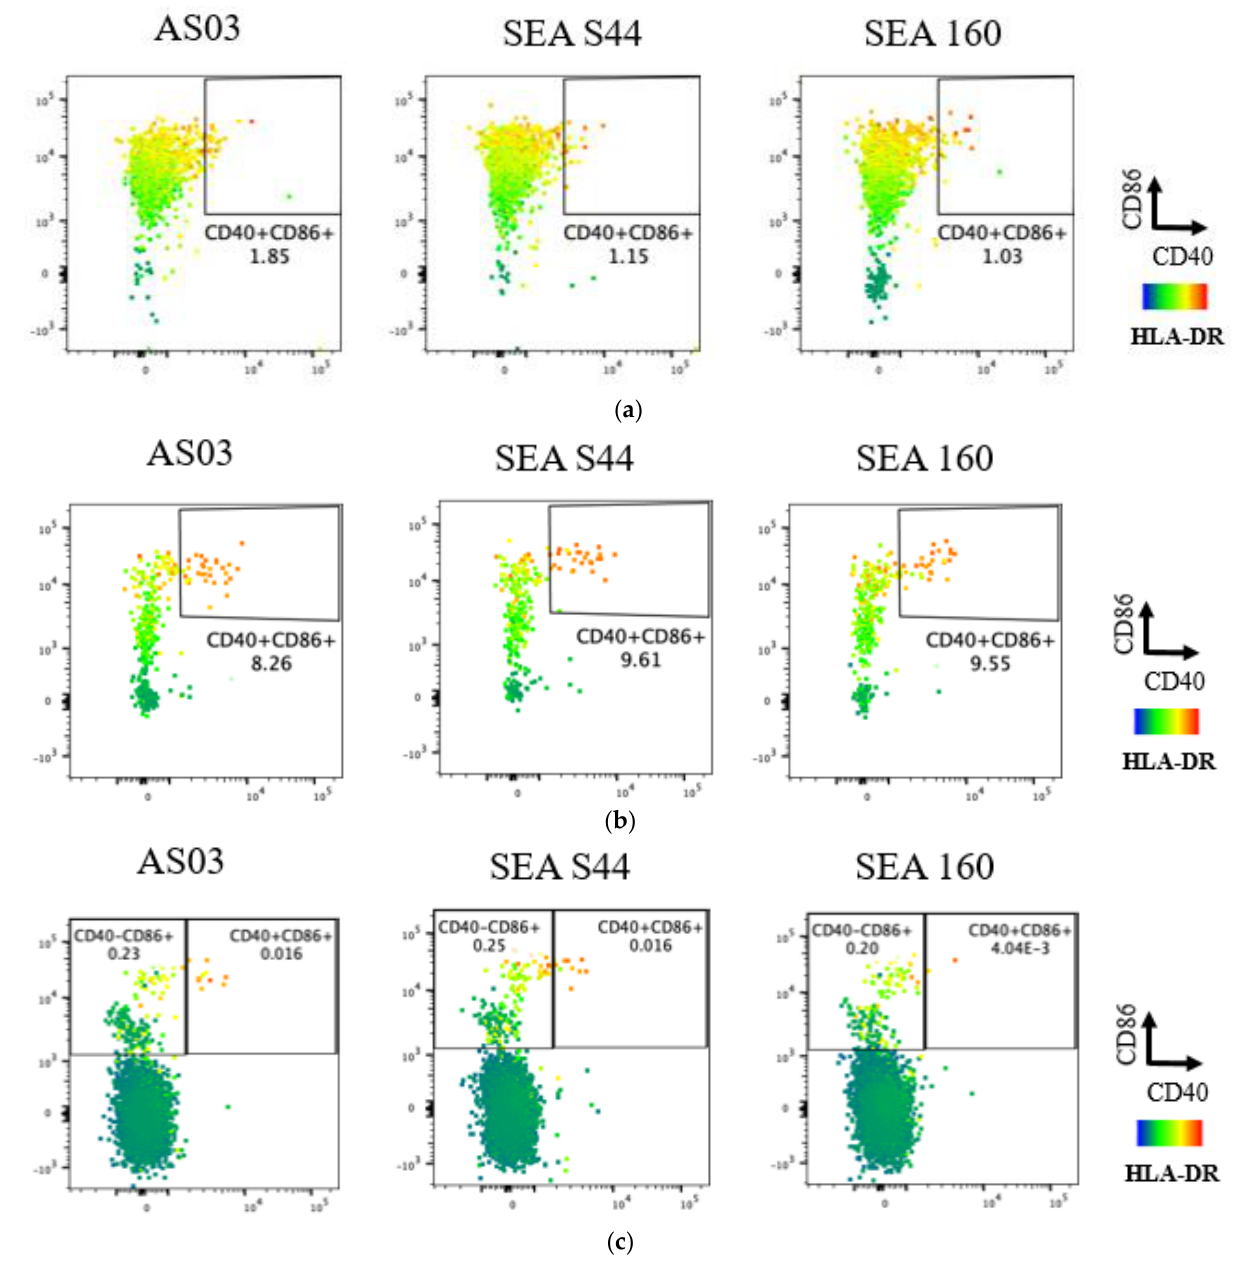
Figure 2. Representative pseudo-color plots showing the tri-variate analysis of CD40 vs. CD86 markers with characterization of HLA-DR expression using heatmap analysis of human whole blood samples stimulated with adjuvants (AS03, SEA S44, and SEA160) with media-treated and ex vivo stained samples as negative controls. AS03, SEA S44, and SEA160-stimulated whole blood samples showed an increase in CD40, CD86, and HLA-DR markers compared to media-treated samples in monocytes ( a ), mDC ( b ), and neutrophils ( c ), indicating induction of an antigen-presentation role.